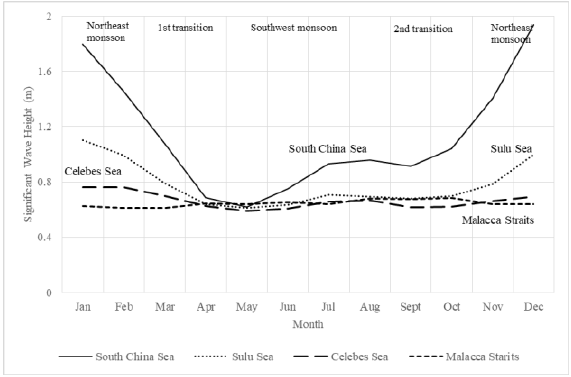
Figure 13. The trend-line of significant wave height for each sea